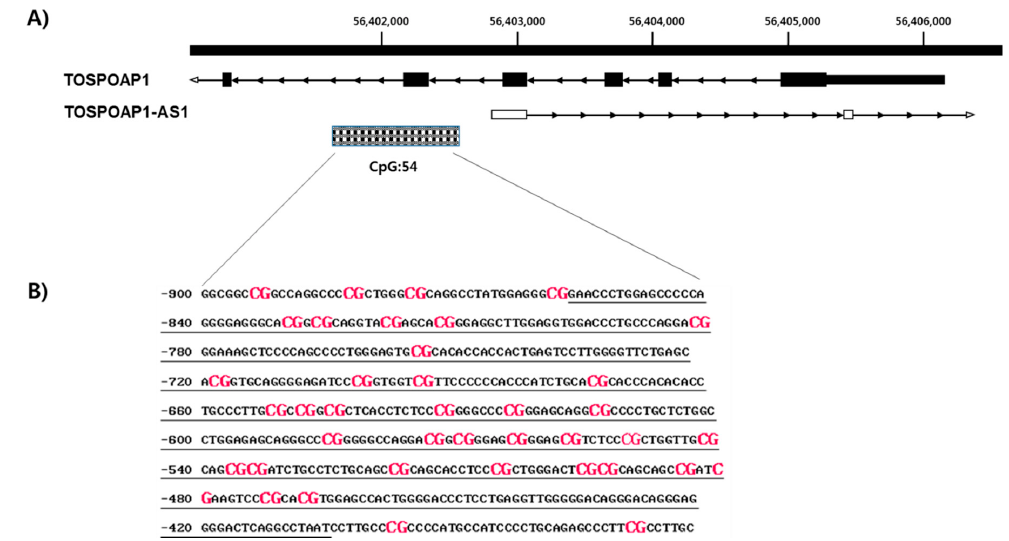
Figure 1. Analysis of hypermethylated CpG sites in TSPOAP1-AS1 promoter region. ( A )Black box and arrow line showed the TSPOAP1-AS1 and TSPOAP1 gene and dot box indicate CpG island region located at 5 ′ -flanking region of TSPOAP1-AS1. Dot line means the position of DNA methylation analysis in this study. ( B ) The sequence of TSPOAP1-AS1 promoter region. The CpG site was shown in red label and the analyzed region in this study showed in underline.